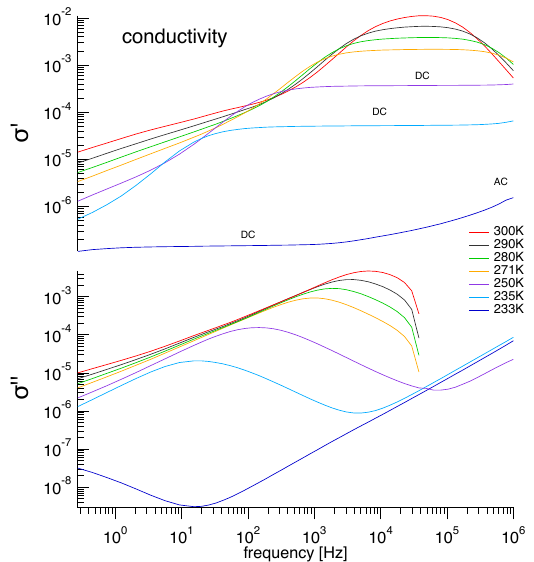
Figure 12. Conductivities as measured on phosphoric acid (PA) with the setup for simultaneous n-DE-spectroscopy. Upper fig- ure: real part of the conductivity σ (cid:48) and lower part of the figure the imaginary part σ